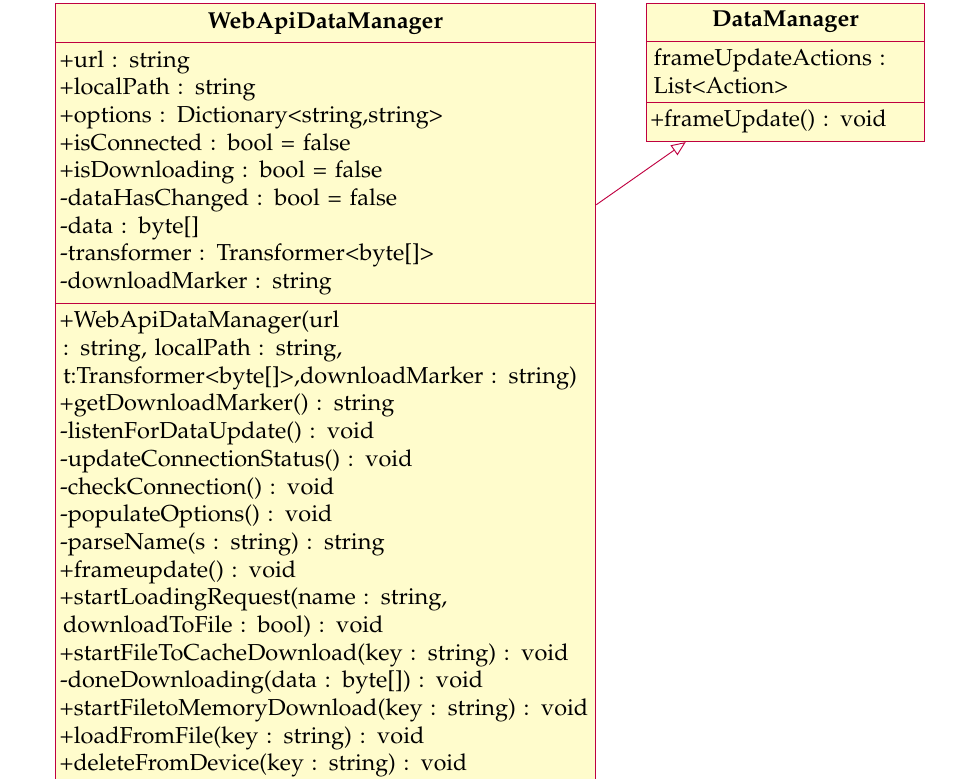
Figure 16. Class diagram of the WebApiDataManager with all the functions and fields and its connection to its parent class.